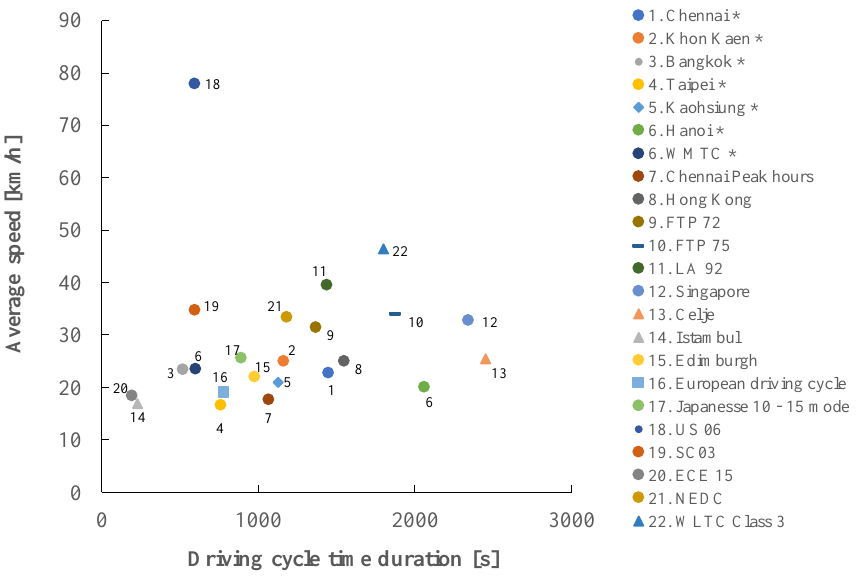
Figure 1. DC duration and average speed for DC developed for different regions or cities. * denotes DC for motorcycles.